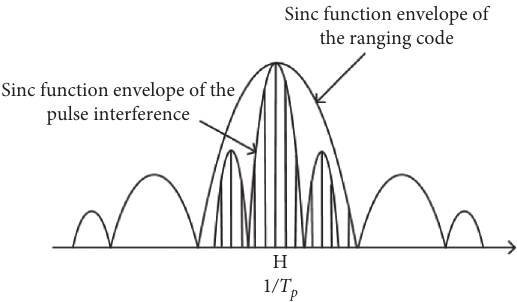
Figure 13: Sinc function envelope of the pulse interference and ranging code spectrum line ( T